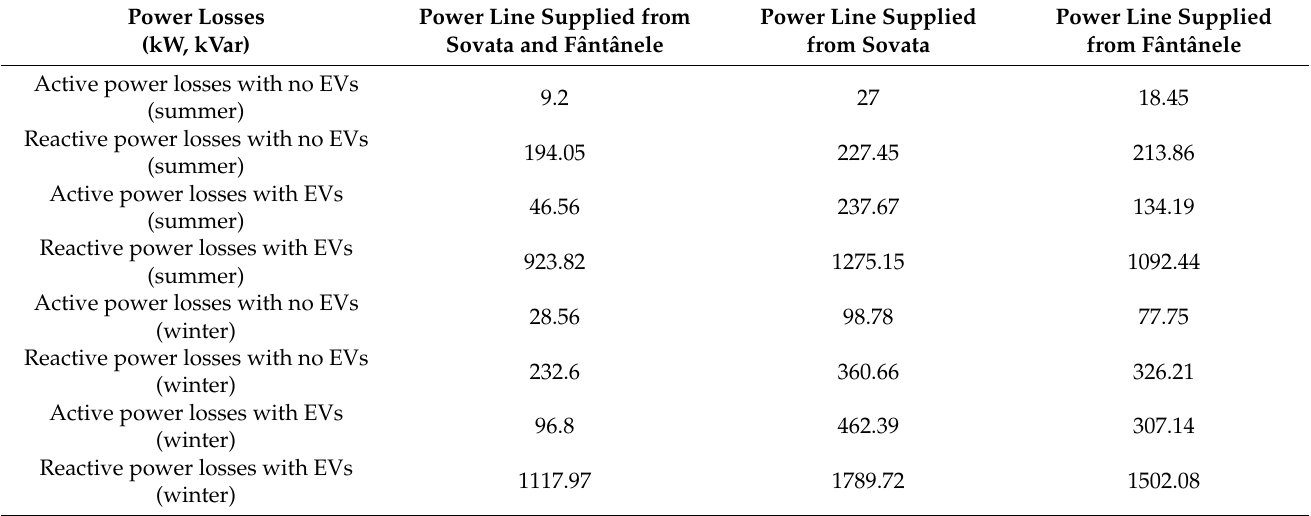
Table 16. Power losses at 9:00 (scenario 3).